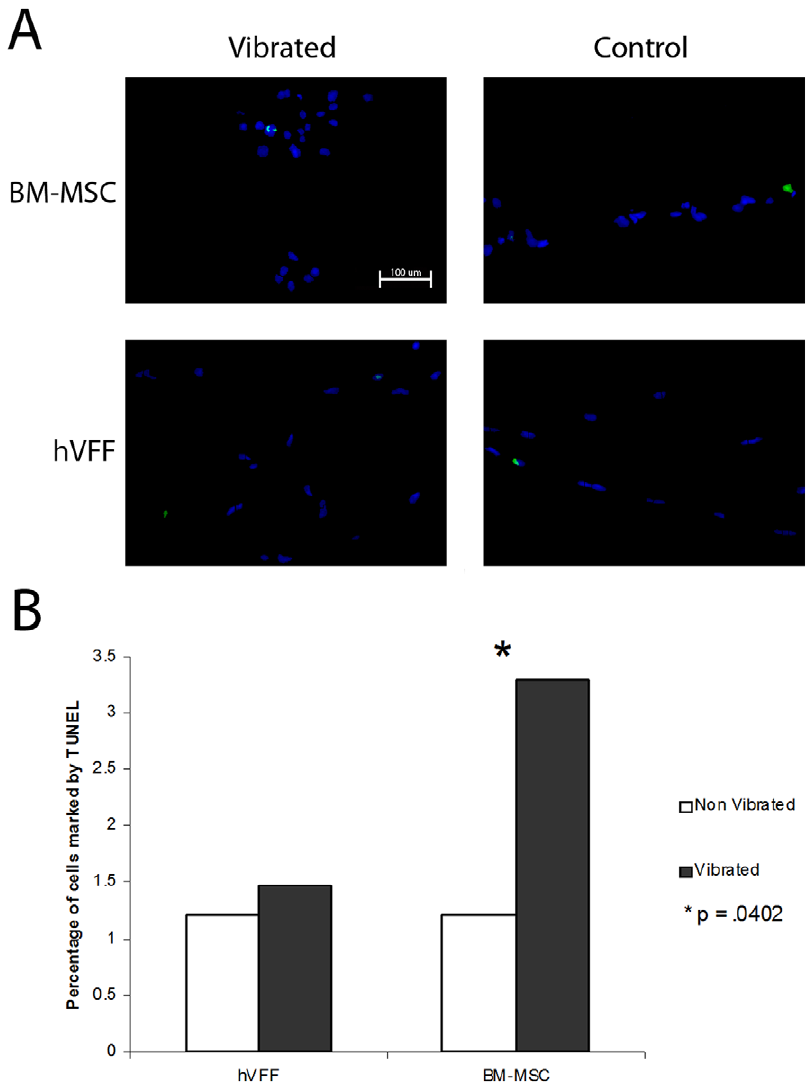
Figure 3. Apoptosis in hVFF and BM-MSC. A. Representative 20 6 pictures of vibrated and control immunohistochemistry sections for each cell type. Apoptotic cells are marked by FITC (green), cell nuclei DAPI (blue). B. The percentage of proliferating cells under each condition. An increase in apoptosis is observed with vibrated BM-MSC compared to controls. * (p=.0402).